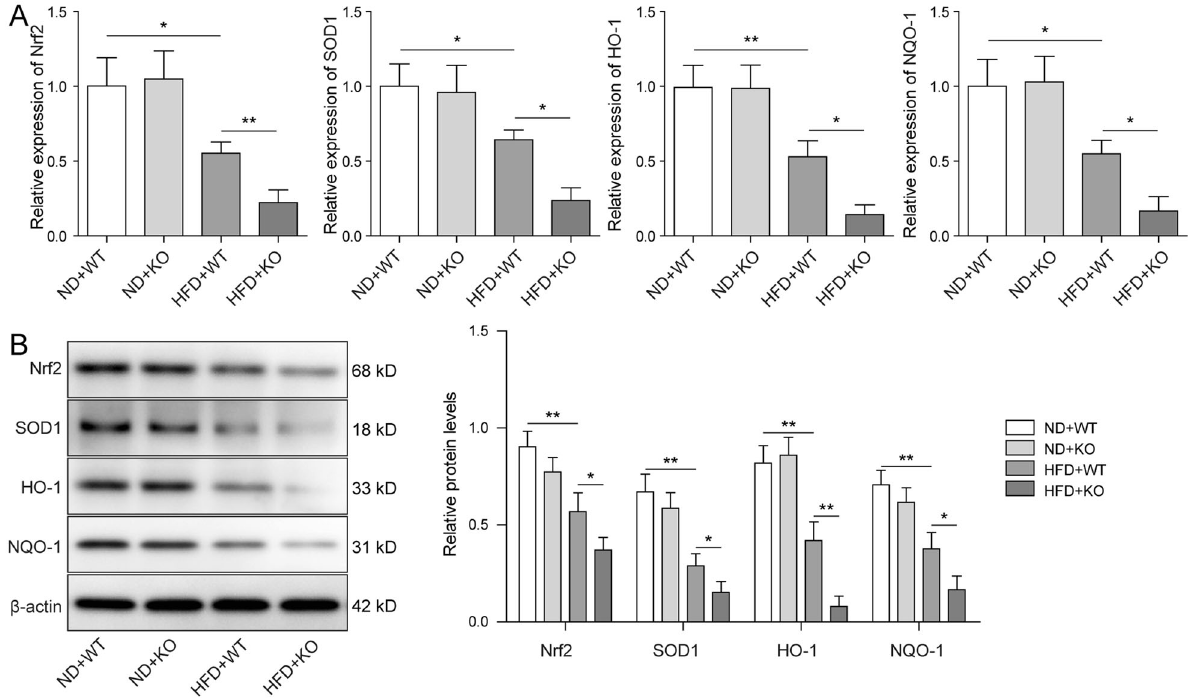
Fig. 3 Nrf2 signaling pathway was inhibited in ACE2-de fi cient ORG mice. A , B The mRNA and protein expression levels of the Nrf2 pathway elements including Nrf2, SOD1, HO-1, NQO-1 were determined by qRT-PCR and western blot, respectively. The expression of Nrf2 and Nrf2 pathway effectors was decreased by HFD treatment and further eliminated in HFD + ACE2-KO mice. Data were representative images or were expressed as the mean ± SD of n = 3 experiments. * P < 0.05, ** P <